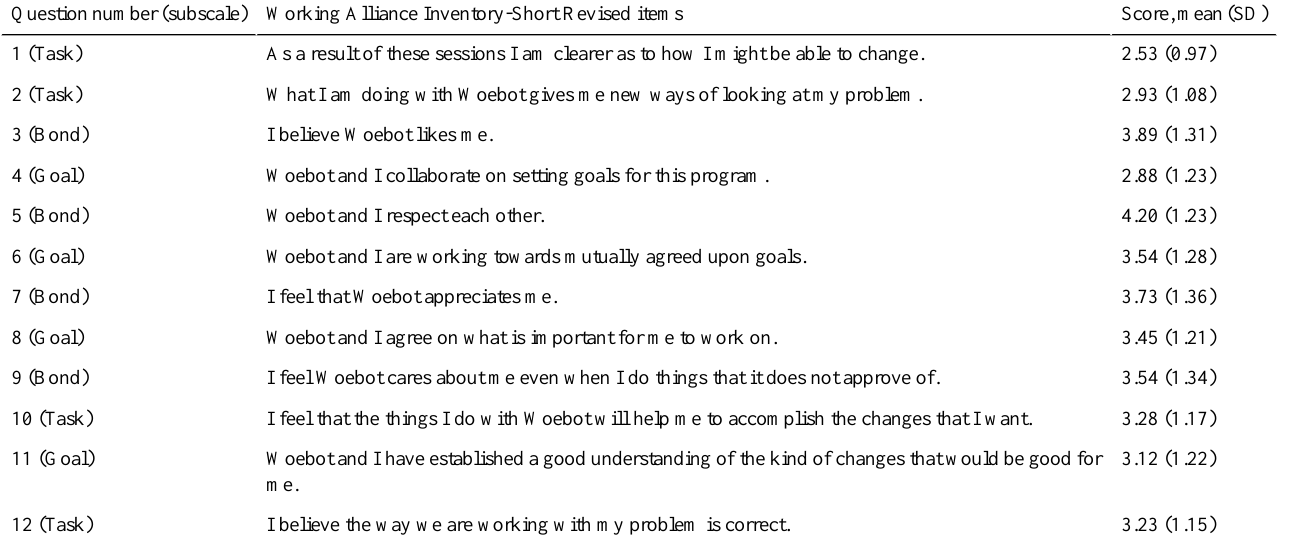
Table 1. Item-level descriptive